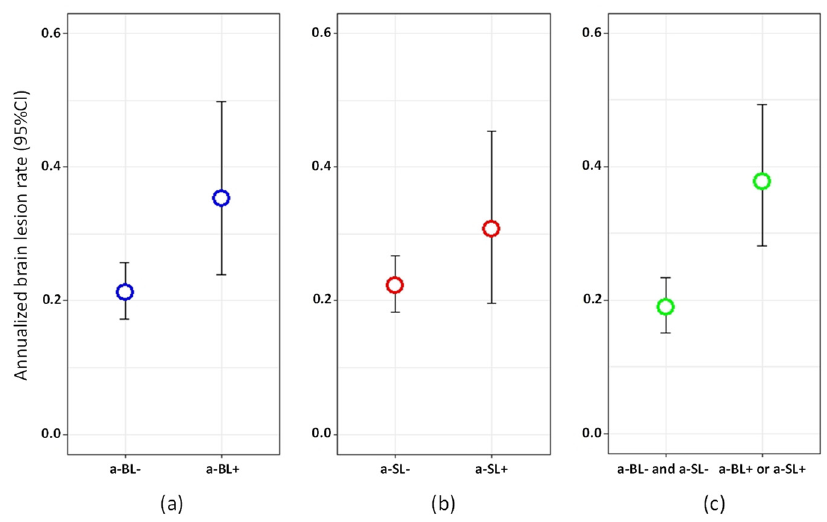
Figure 3. Annualized brain lesion rate between T2 and T3 in: ( a ) patients with vs. without asymptomatic brain lesions (a-BL) at T2; ( b ) patients with vs. without asymptomatic spinal lesions (a-SL) at T2; ( c ) patients with either a-BL or a-SL vs. neither a-BL nor a-SL at T2.